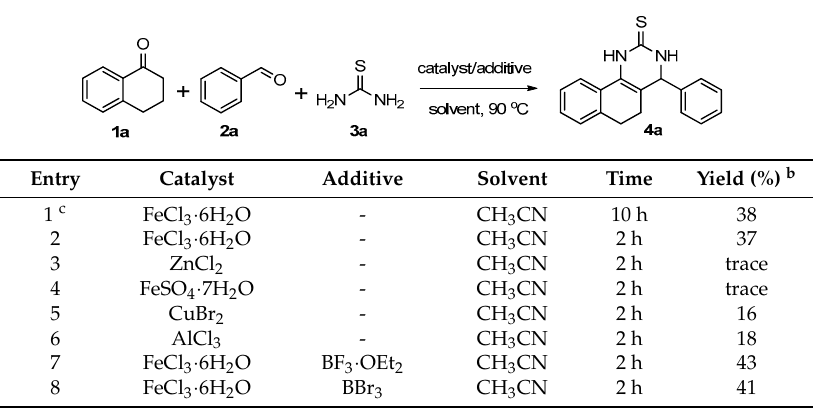
Table 1. Optimization of the reaction conditions a .